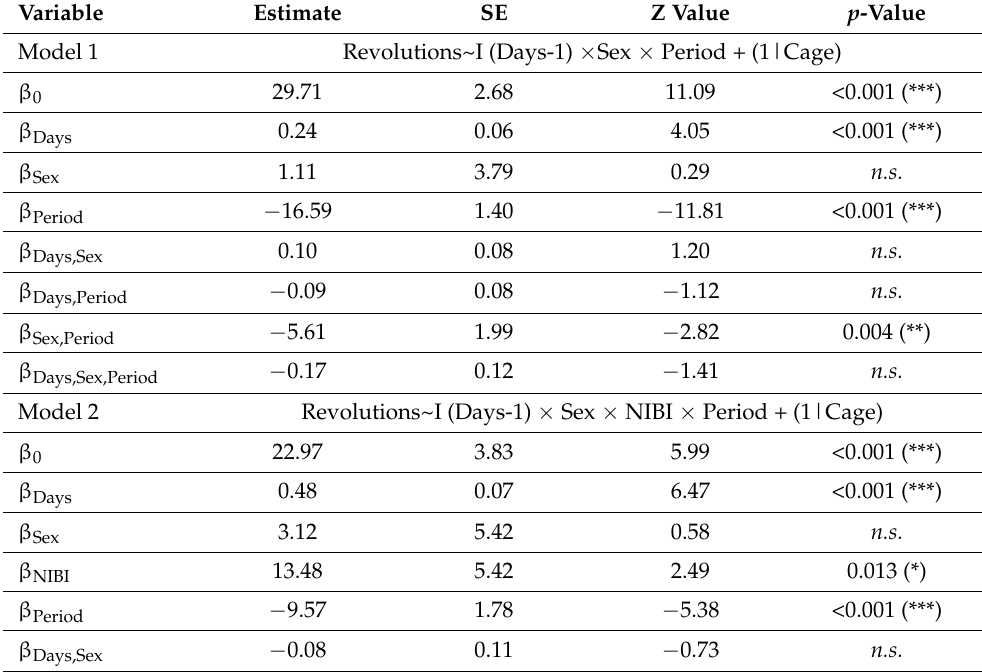
Table 1. Results for the linear mixed-effects models assessing the activity in the RW by days (Model 1) and adjusted by previous NIBI behavior in the CT (Model